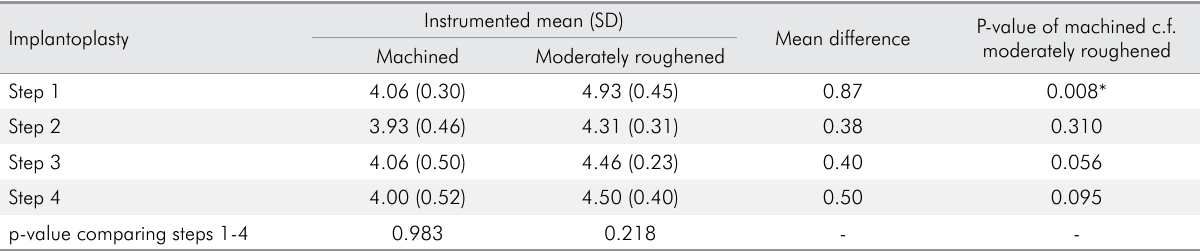
Table 3. Ra value comparison of instrumented machined and moderately roughened surfaces, at all steps.